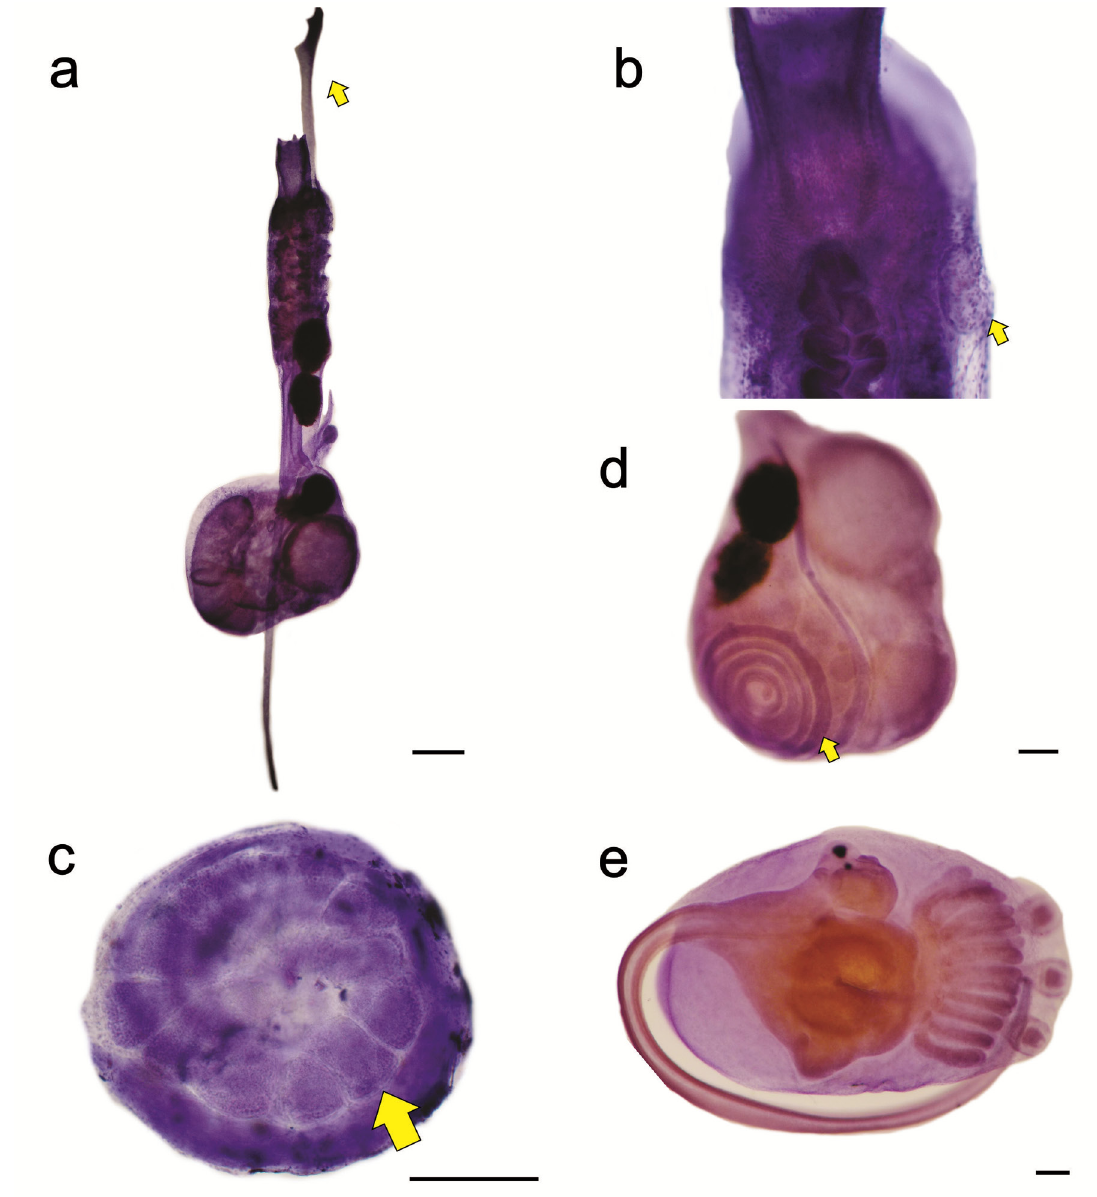
Fig. 9. Polysyncraton magnilarvum (Millar, 1962), stained with hemalum. a . Zooid (arrow pointing at atrial languet). b . Ventral view of the anterior region of the thorax (arrow indicating the lateral thoracic organ). c . Testis follicles (arrow indicating one lobe). d . Abdomen (arrow indicates the sperm duct) (MNHN A2-2466). e . Larva (MNHN A2-2467). Scale bars: a = 0.2 mm; c–e = 0.1